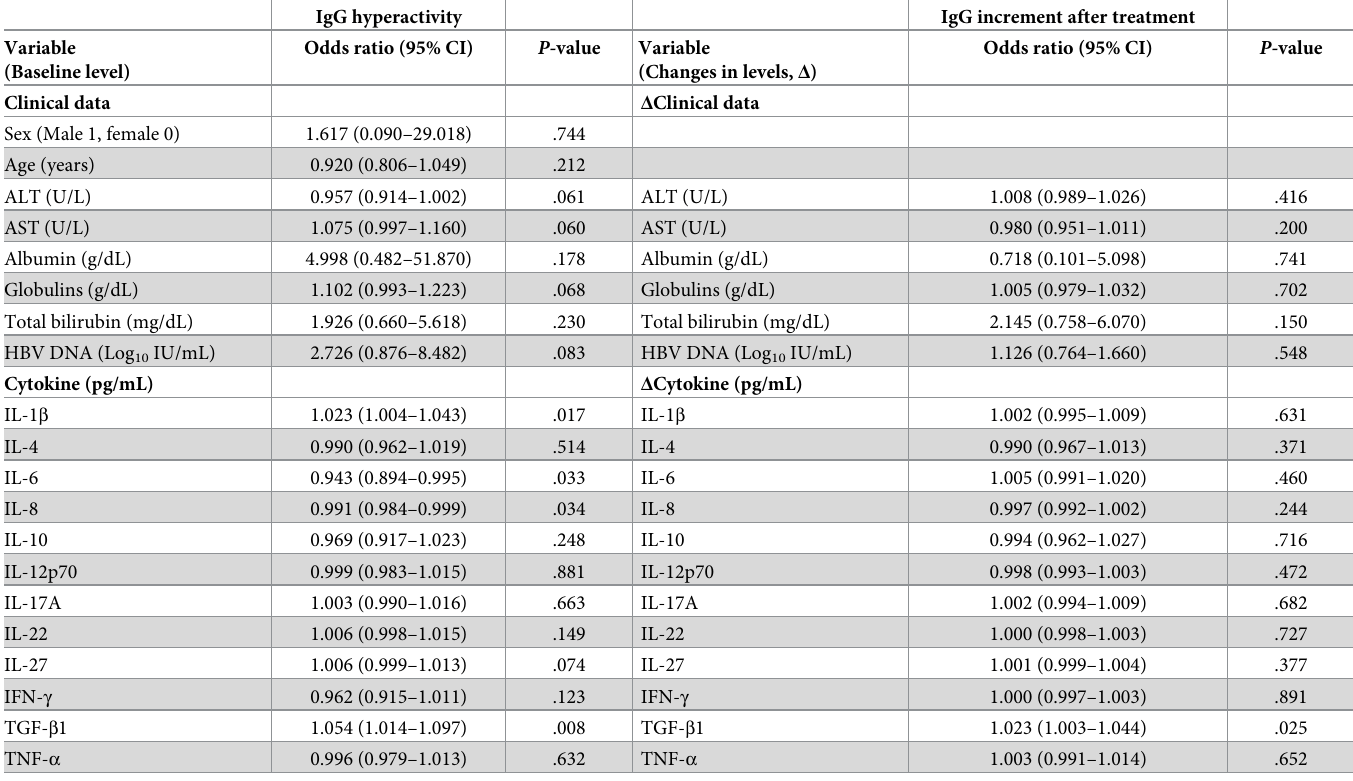
Table 3. Multivariate logistic regression analysis of factors that are associated with the hyperactivity ( > 2 g/dL) or post-treatment increment of IgG in patients with HBV-related liver cirrhosis (n = 68). IgG hyperactivity IgG increment after